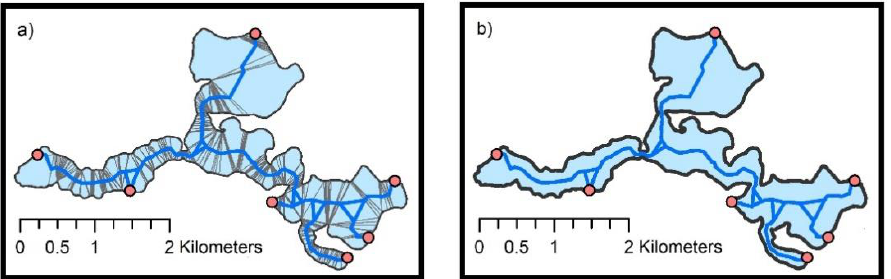
Figure 21. Skeleton of a polygon generated based on 7 base points marking attractive sites on the lake shore. The skeleton can be used for navigation; ( a ) generation process; ( b ) results.